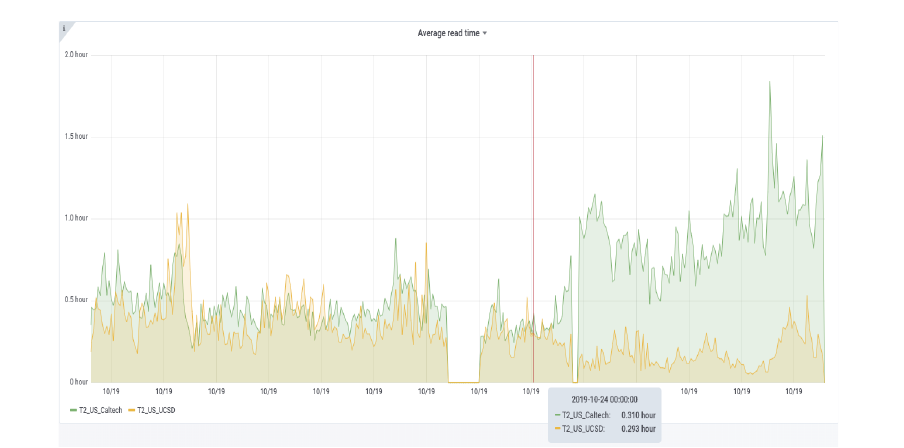
Figure 4. Average total read time for analysis jobs using MINIAOD at Caltech and UCSD. The X-axis are the dates and in the Y-axis is the average read time for in hours for a job. The red-line is when Caltech experimented not reading from cache but reading from the AAA